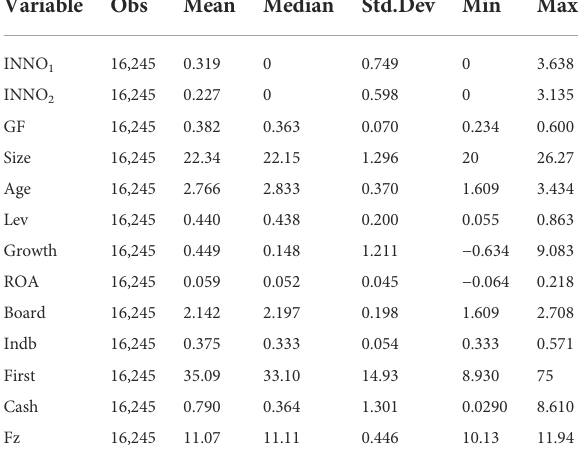
TABLE 1 Descriptive statistical results of each